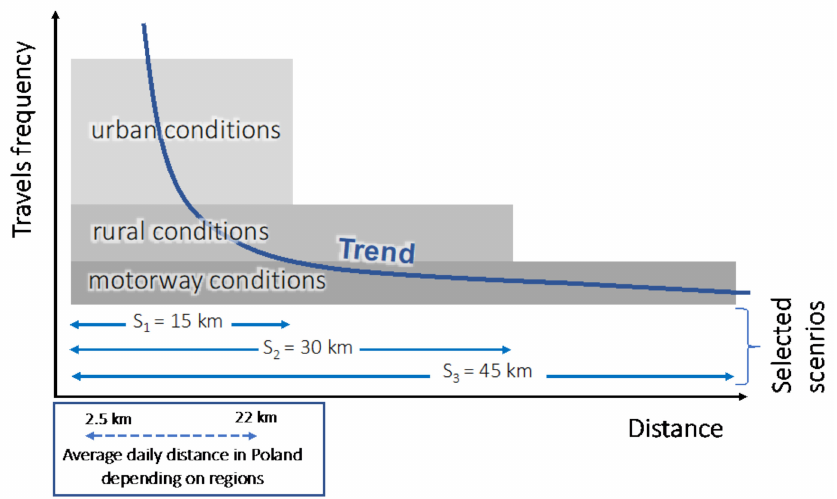
Figure 5. Typical distribution of frequency of trips vs. distance covered in Italy [50], supplemented by proposed scenarios and statistical data on average distances covered in Poland